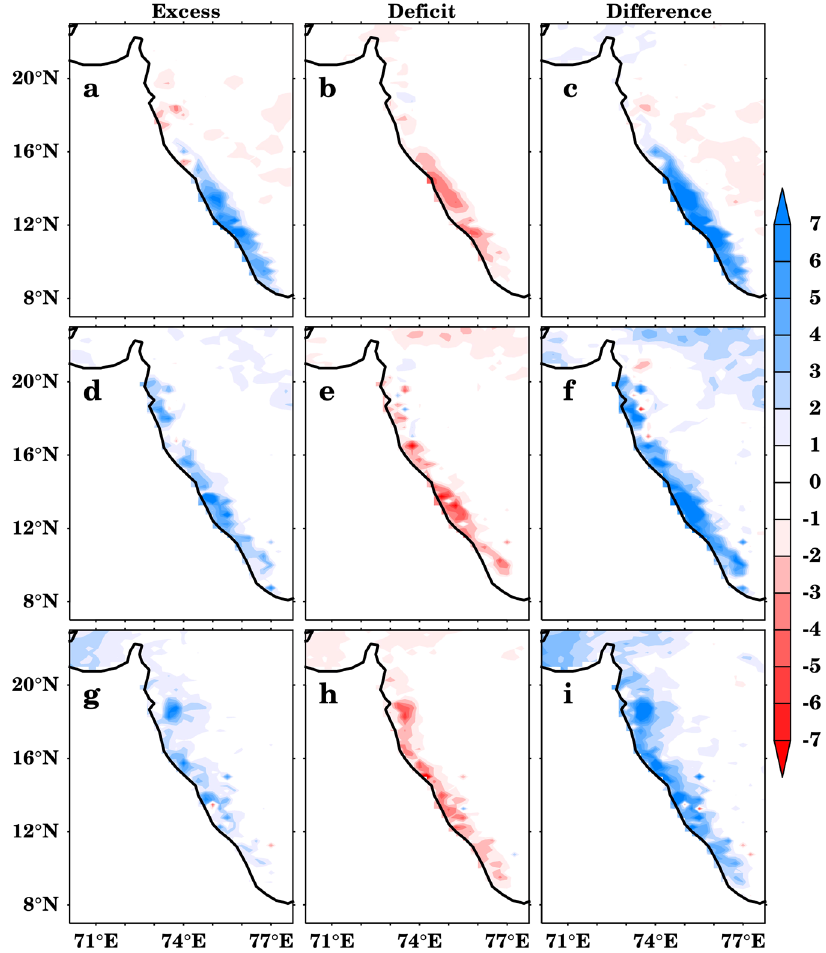
Fig. 3 Spatial distribution of rainfall over WG for excess and de fi cit phases. Composite of summer monsoon rainfall anomaly (mm/day) over WG from IMD for a excess, b de fi cit years, and c their difference ( a , b ) for period 1 (1901 – 1942). d , e , and f same as a , b , and c but for period 2 (1943 – 1977). g , h , and i same as a , b , and c but for period 3 (1978 –